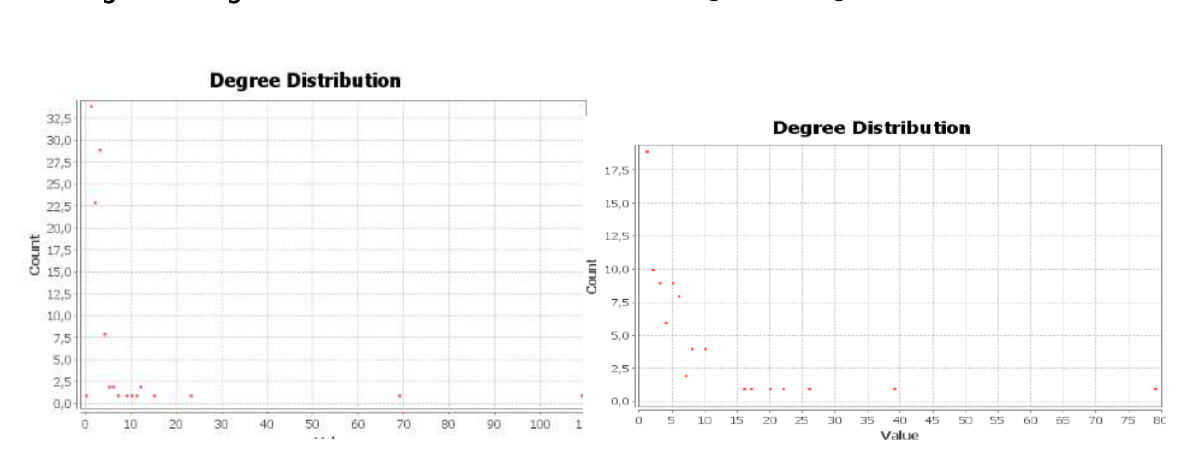
Figure 10: Degree Distribution 2017 Figure 11: Degree Distribution 2018